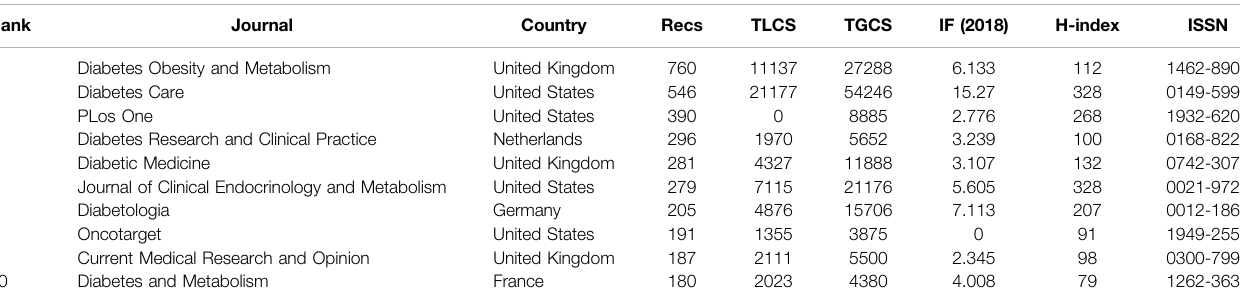
TABLE 4 | The top 10 journals ranked by their Recs in metformin